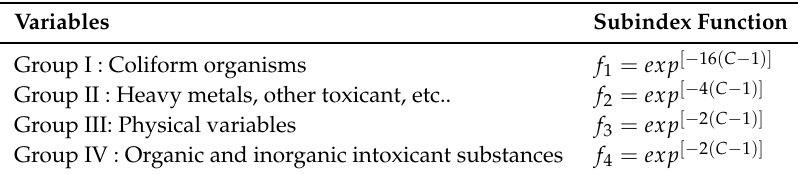
Table A5. Subindex Functions of Bhargava’s Index.